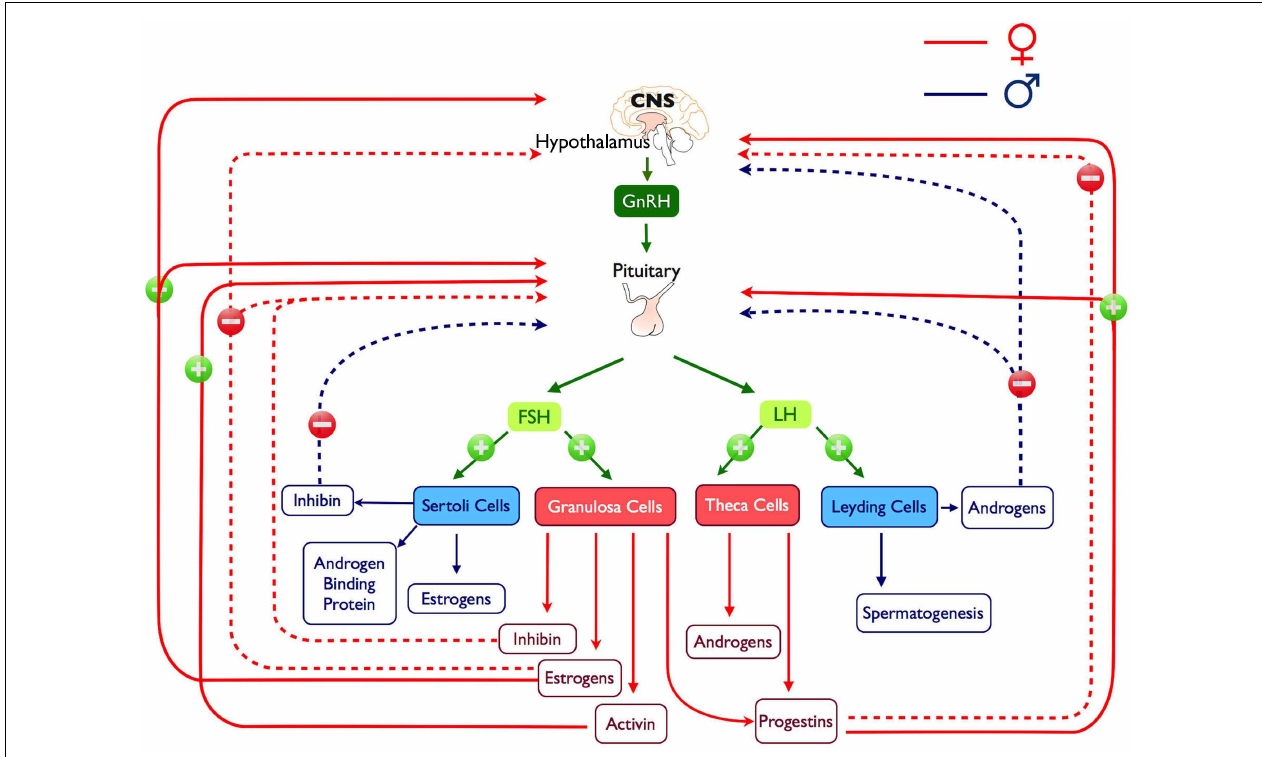
FIGURE 2 | Representation of the hypothalamus-pituitary-gonadal axis, positive and negatives feedback loops and products are illustrated